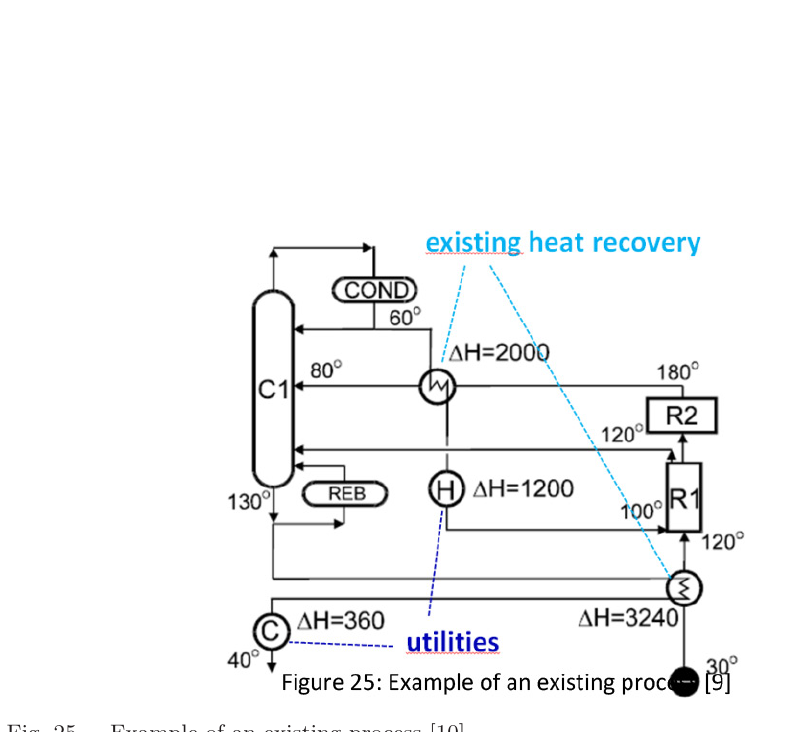
exchangers) is not taken into account as these may not be optimally positioned. Hot streams are process flows that need cooling, cold streams need heating. In the case of sensible heat, so no phase change occurs, we calculate the “heat capacity flow rate” CP for all basic processes as the exchanged heat divided by Δ T . Logically, heat is extracted when the temperature drops.